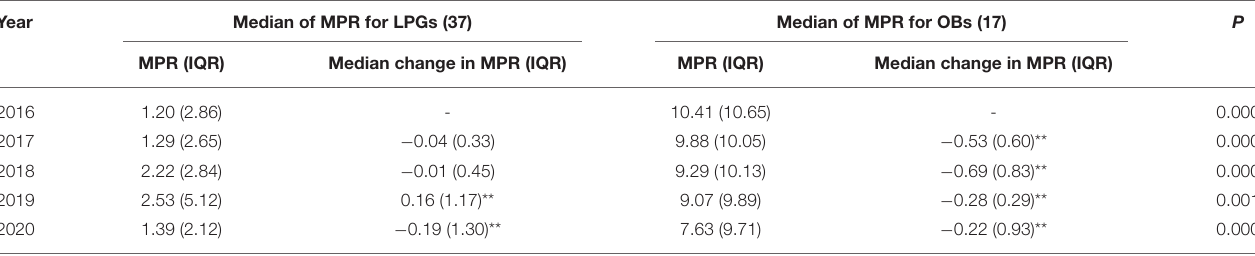
TABLE 2 | Median MPR of essential medicines in Nanjing from 2016 to 2020.